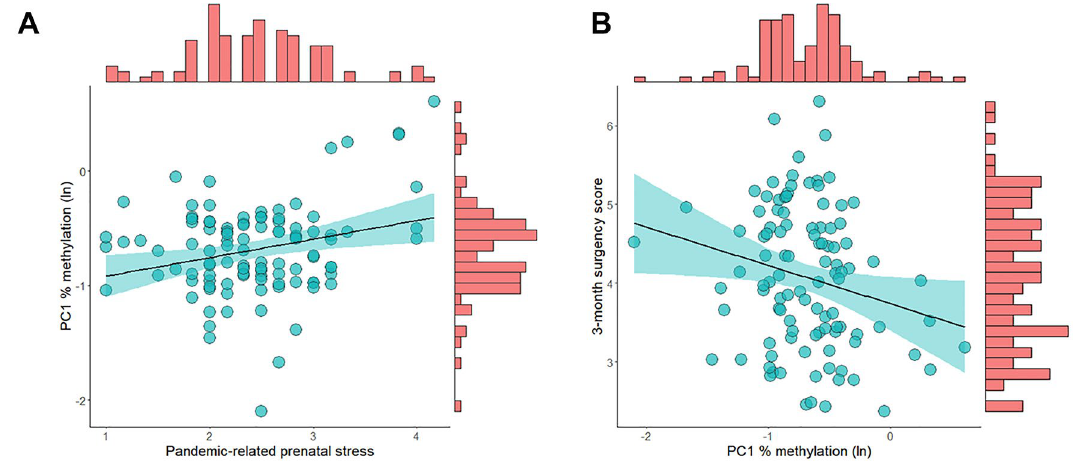
Figure 4. Association between ( A ) COVID-19-related prenatal stress and infants’ SLC6A4 PC1 methylation; ( B ) infants’ SLC6A4 PC1 methylation and 3-month surgency